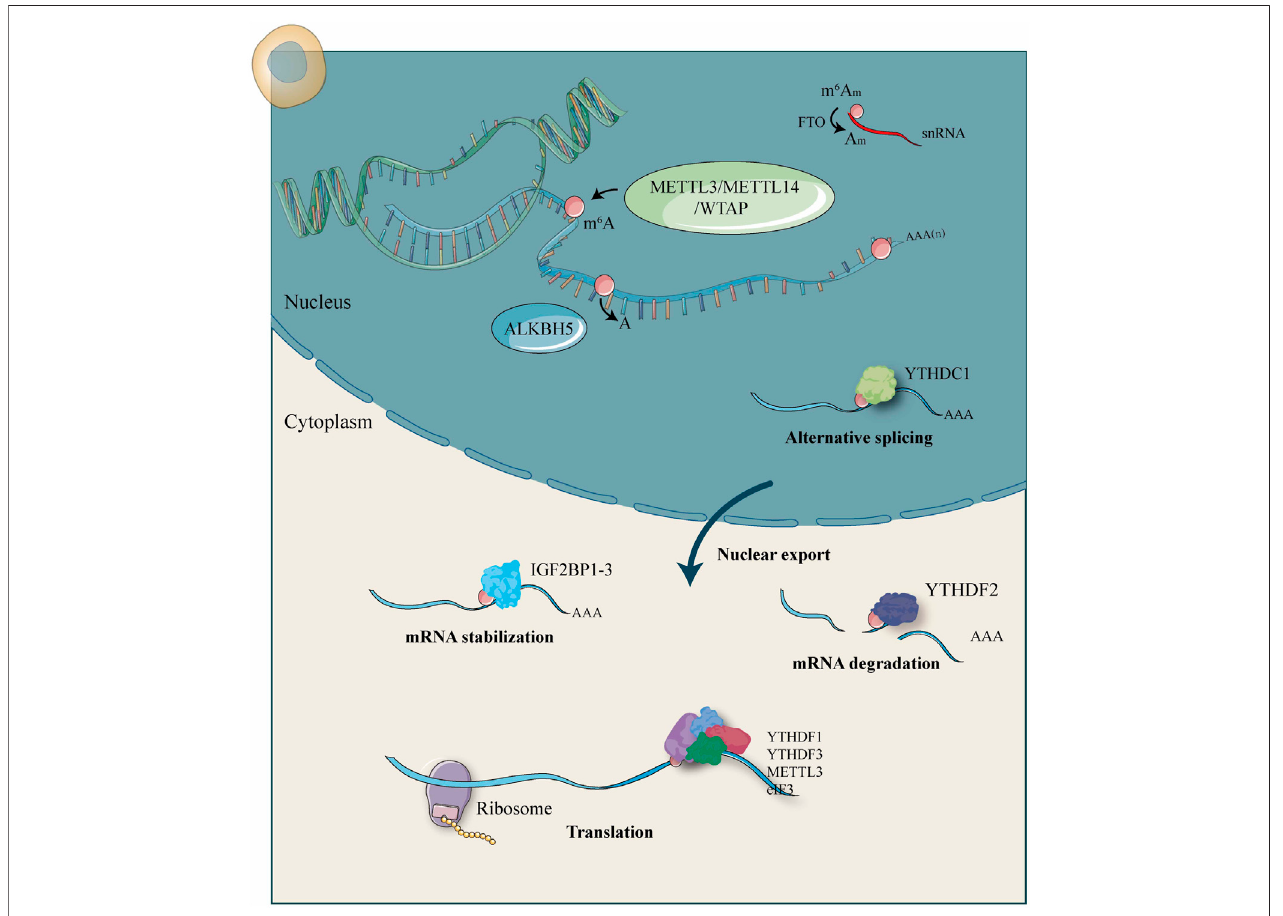
FIGURE 1 | Molecular functions and mechanisms of m 6 A RNA methylation by m 6 A “ writer, ” “ eraser, ” and “ reader ” proteins.